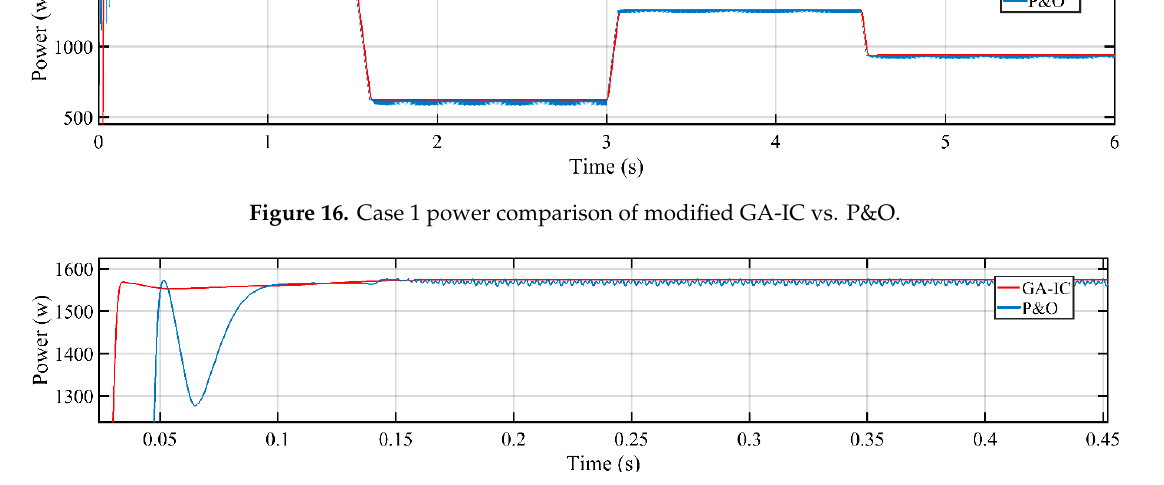
Figure 17. Case 1 power comparison of modified GA-IC vs. P&O.